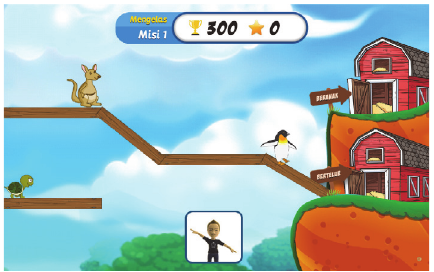
Figure 9: A screenshot of the game.